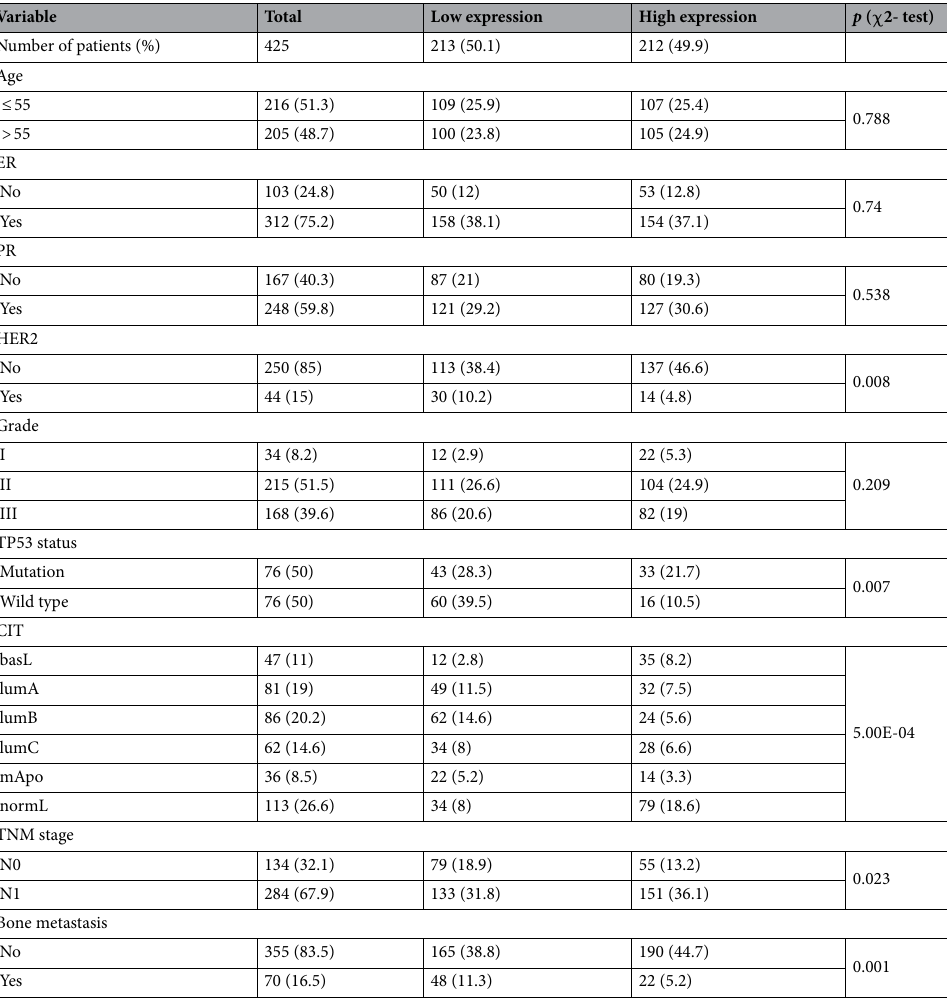
Table 1. Clinicopathological features of breast cancer patients in two groups based on median expression of TOR1B